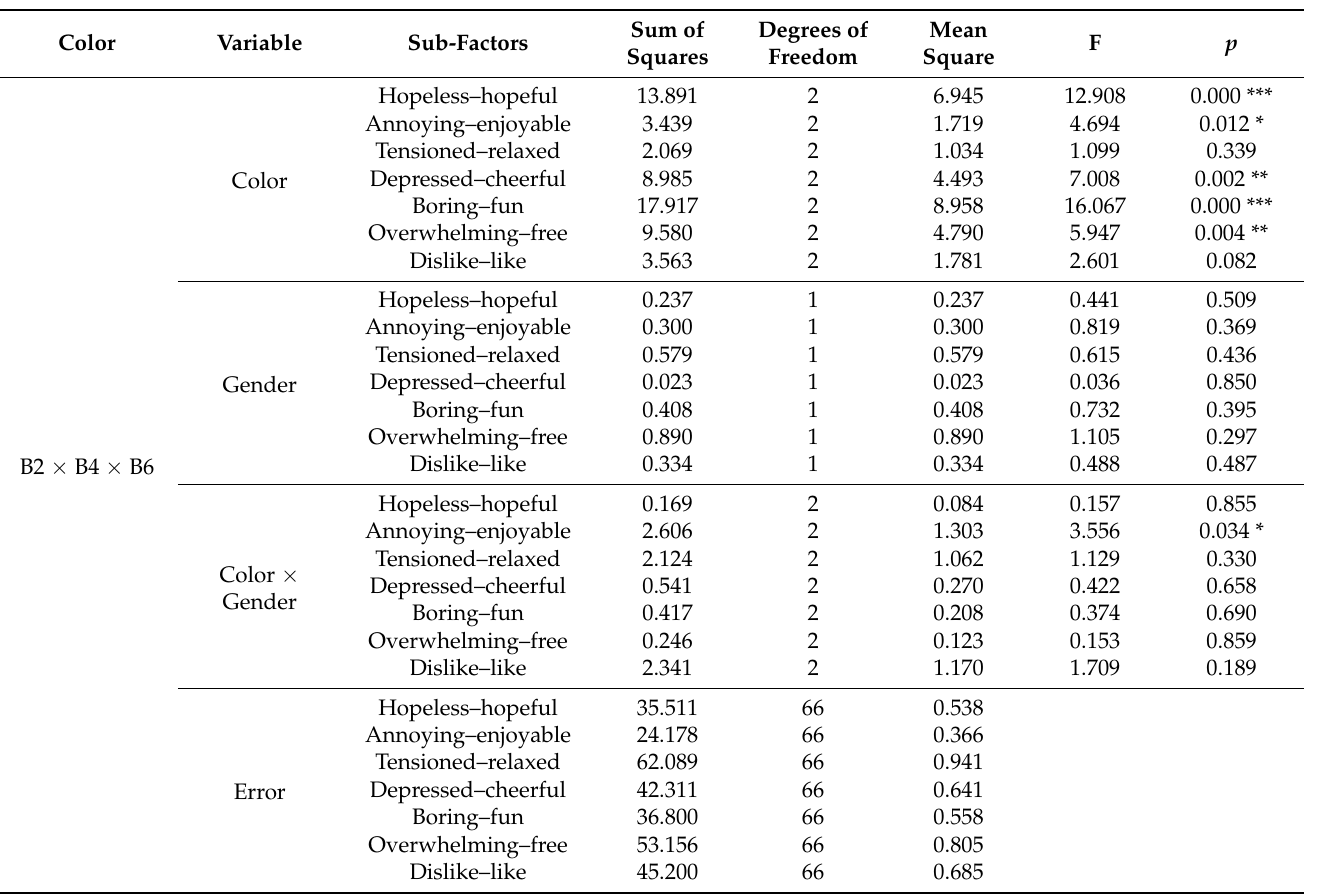
Table 13. Main effect and interaction effect of stress according to chroma changes under blue hue and high-value